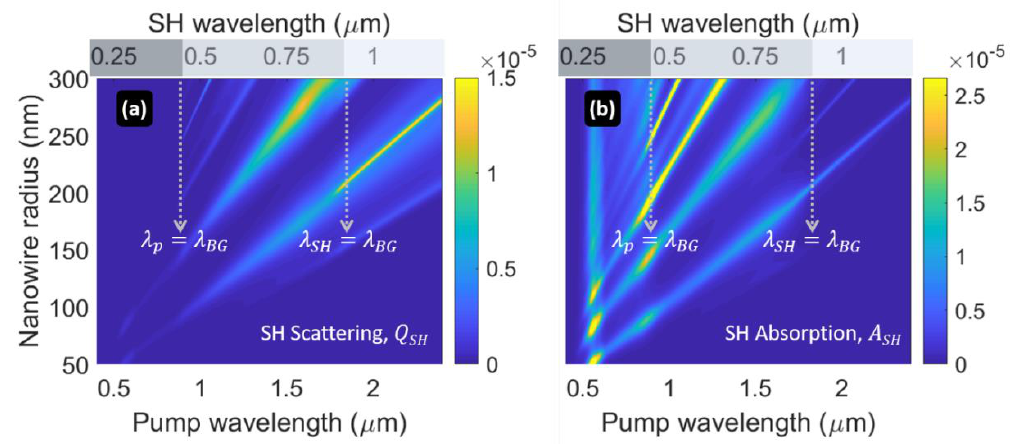
Figure 7. ( a ) Same as Figure 4b. ( b ) SH absorption 𝐴 𝑆𝐻 , as a function of pump/SH wavelength and nanowire size. The dark-shaded portion of the SH wavelength axis indicates the opaque region for both pump and SH light ( 𝜆 𝑝 ≤ 𝜆 𝐵𝐺 ); the medium-shaded portion indicates a region that is transparent for the pump but absorptive for the SH ( 𝜆 𝑆𝐻 < 𝜆 𝐵𝐺 < 𝜆 𝑝 ); the light-shaded portion indicates the transparent range ( 𝜆 𝑆𝐻 ≥ 𝜆 𝐵𝐺 ).